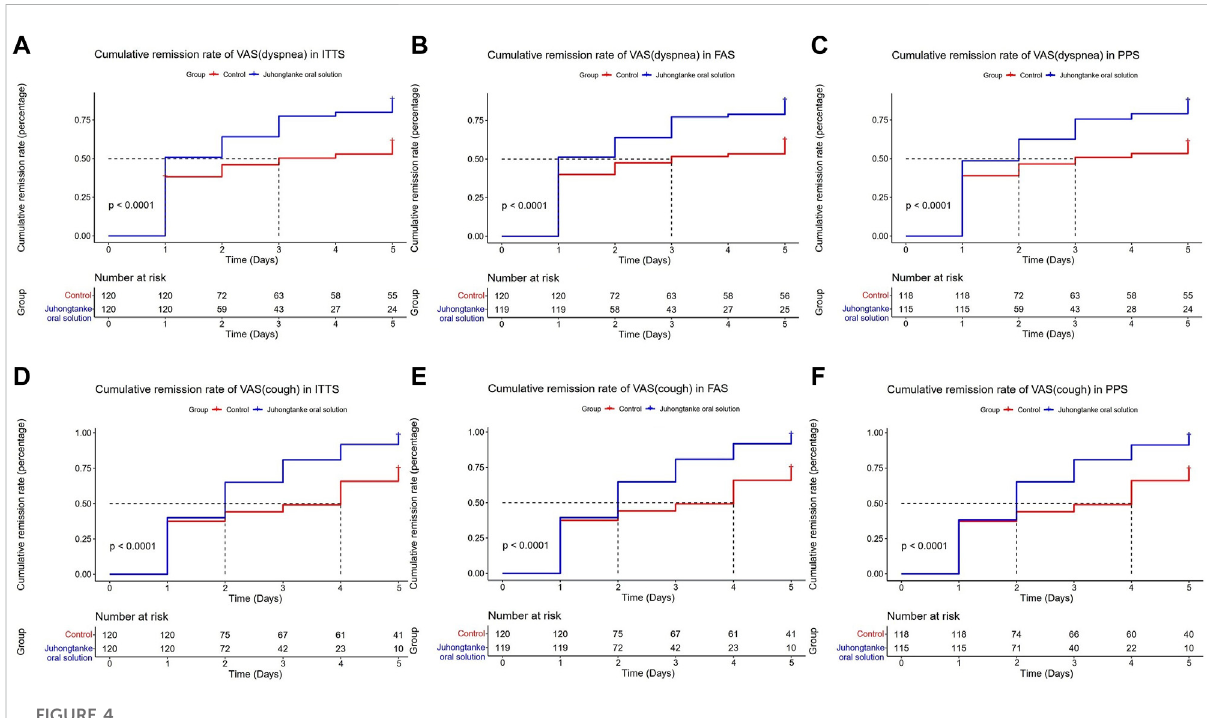
FIGURE 4 Cumulative remission rate of VAS (dyspnea and cough) between the Juhongtanke oral solution and control groups in the ITTS (A,D) , FAS (B,E) , and PPS (C,F) .